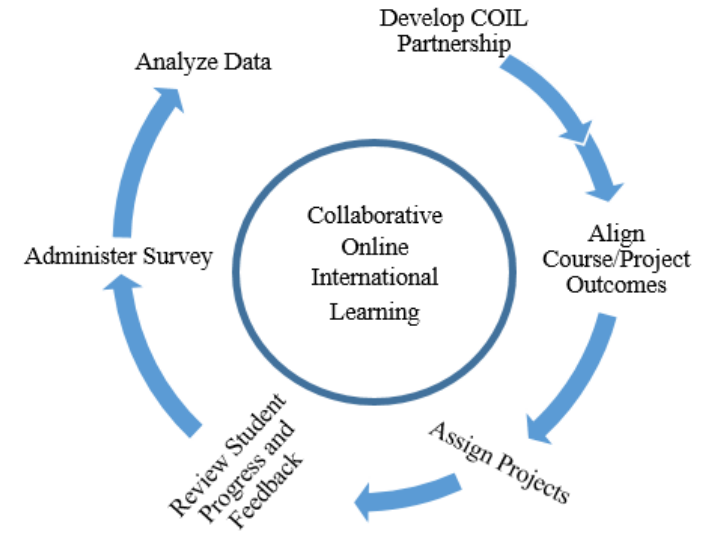
Fig. 1. The COIL Research